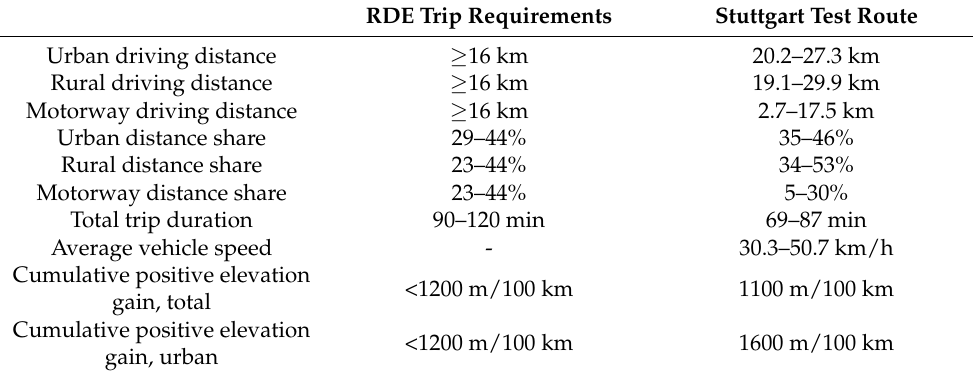
Table 1. Comparison of the Stuttgart test route characteristics and the real driving emissions (RDE) trip